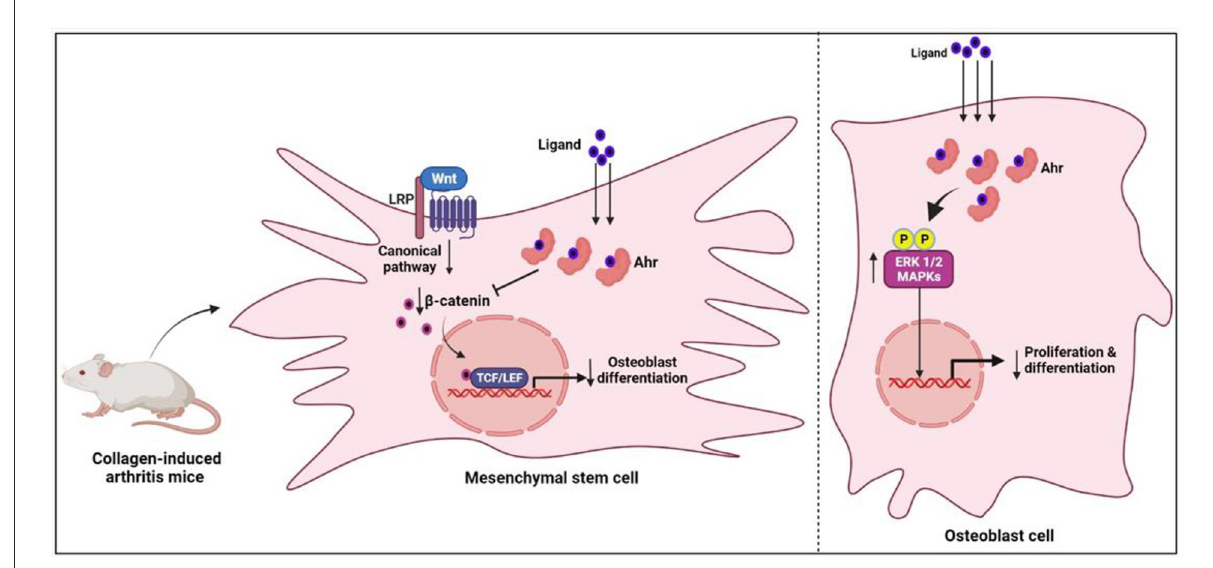
FIGURE5 The mechanism of osteogenesis inhibition by Ahr-associated mesenchymal stem cell via the Wnt/-catenin pathway. Ahr, aryl hydrocarbon receptor; ERK1/2, extracellular signal_regulated protein kinase; MAPK, mitogen-activated protein kinase.